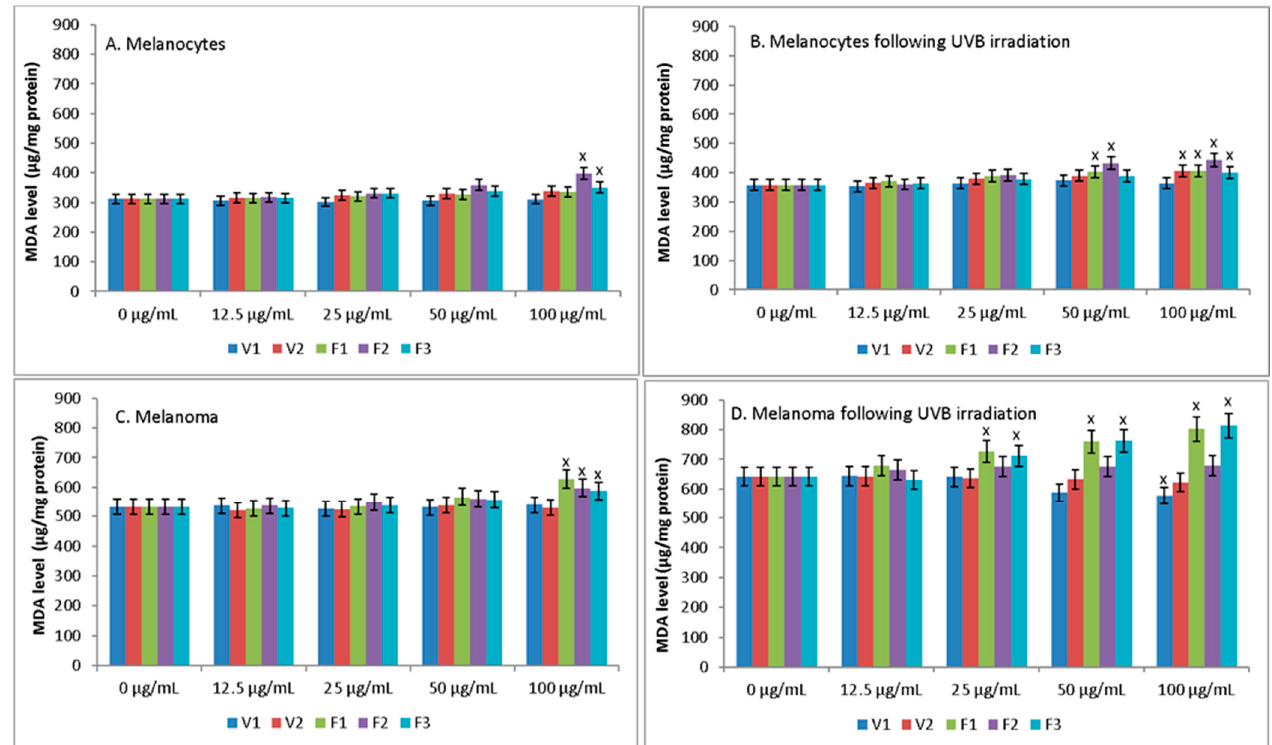
Figure 6. The level of MDA in melanocytes ( A , B ) and melanoma cells ( C , D ) following treatment with extract of Satureja hortensis L. (concentration range 12.5–100 µg/mL) and/or UVB (300 mJ/cm 2 ) irradiation. Mean values ± SD of three independent experiments are presented. x statistically significant differences vs. control group (0 μ g/mL), p < 0.05.